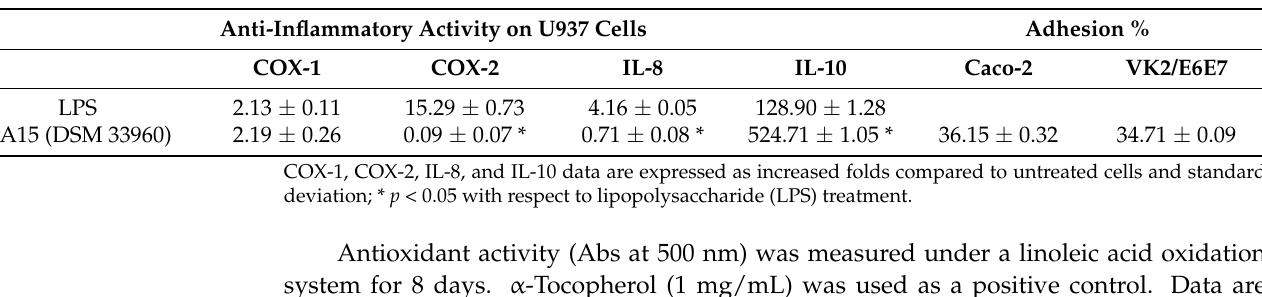
Table 4. Antioxidant, anti-inflammatory, and adhesion to Caco-2 and VK2/E6E7 cell lines exhibited by the L. rhamnosus CA15 (DSM 33960) strain.